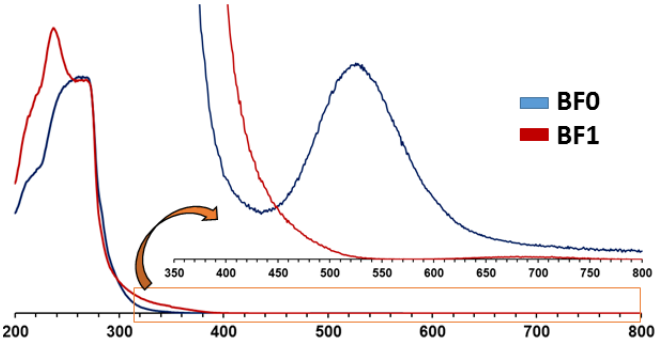
Figure 3. Diffuse reflectance UV/Vis spectra of BF0 and BF1 hybrid surfaces and expanded 350 – 800 nm region.